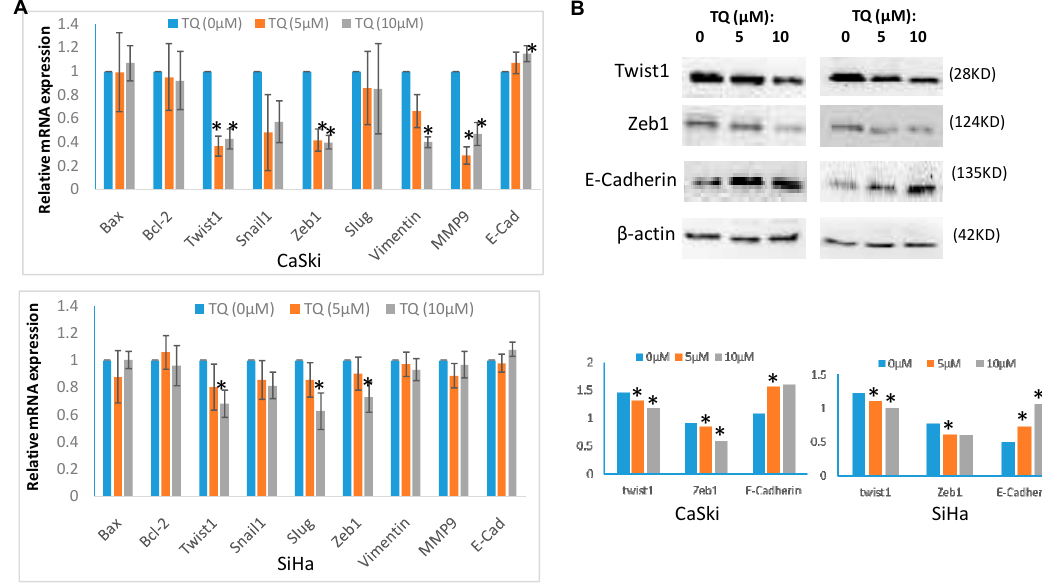
Figure 3. Effects of thymoquinone (TQ) on genetic expression of apoptosis and EMT associated proteins in cervical cancer cells. Real time Q-PCR analysis showed that TQ treatment (5 µM and 10 µM) for 24 h down-regulated mRNA level expression of Twist1 , Zeb1 both in CaSki and SiHa cells. TQ treatment up-regulated E-Cadherin expression too in both CaSki and SiHa cells (* p < 0.05). TQ also inhibits Snail1 , Slug , Vimentin and MMP9 in CaSki, but not in SiHa. N-cadherin , Bax and Bcl-2 expression remained unchanged ( A ). Western blot analysis shows that TQ treatment (5 µM and 10 µM) for treatment inhibits the protein level expression of Twist1, Zeb1 both in CaSki and SiHa cells (* p < 0.05) ( B ).TQ treatment also significantly increased the expression of E-Cadherin in CaSki cells (* p < 0.05) ( B ).